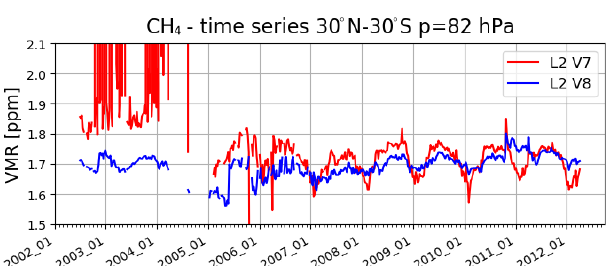
Figure 21. Time series of CH 4 monthly mean profiles in the Trop- ics, at the pressure level of 82hPa generated with MIPAS ESA L2 V7 products (red curve) and L2 V8 ones (blue